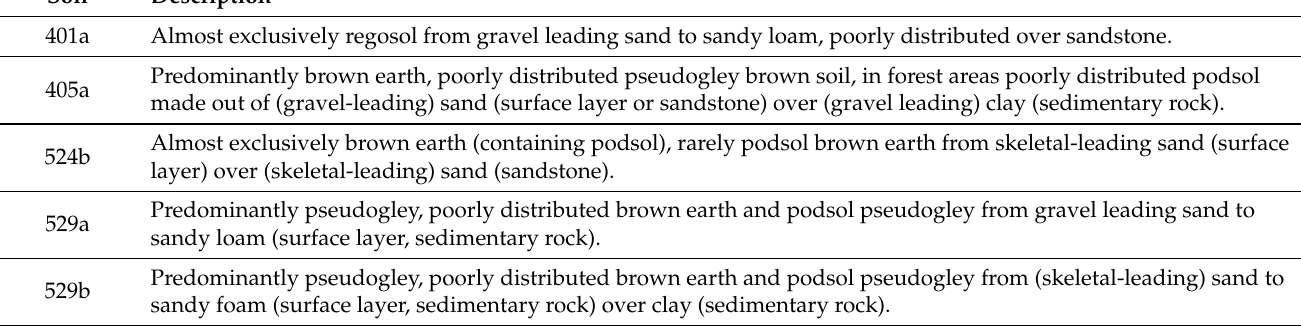
Table 4. Soil types which led to lowest z-score and ∆ Harmonic NDVI values in August 2018 for forest areas with pine as the dominant tree species. Description for each soil type is based on the KA5